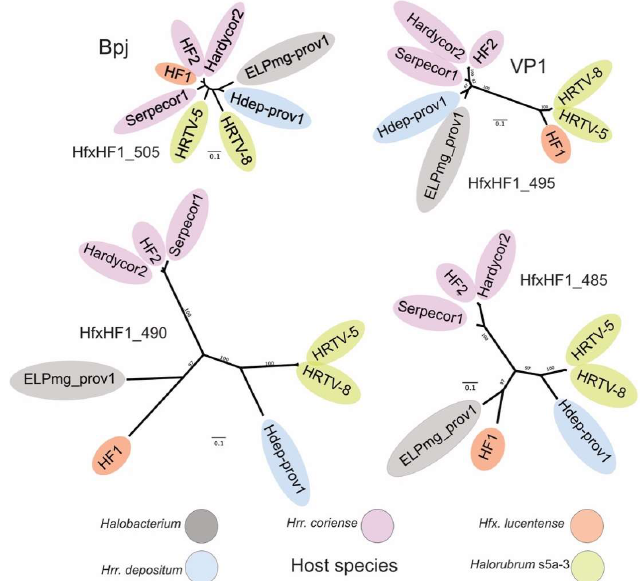
Figure 6. Correlation of host specificity and inferred phylogeny of variable (MDR-B) tail-proteins. Host specificity is indicated by background color, with the key shown below the trees. Homologous proteins were first aligned using MAFFT and trees inferred using PhyloML. Bootstrap values are shown near branch points and the scale bars indicate the number of expected substitutions per site. The trees have been sized so that the scale bars are equivalent. Trees are labeled by the locus tag of the HF1 protein in each homologous group, and the two top trees also have functional indications (Bpj for baseplate J family protein; VP1 for the minor virion protein). HRTV-5 and HRTV-8 were isolated on different strains of Halorubrum (strains s5a-3 and B2-2, respectively) but both infect three strains of Halorubrum (strains s5a-2, s5a-3 and SS1-3) at high EOP, indicating that they share similar RBPs [6]. The proviruses Hdep-prov1 and ELPmg-prov1 are described in the text and Table